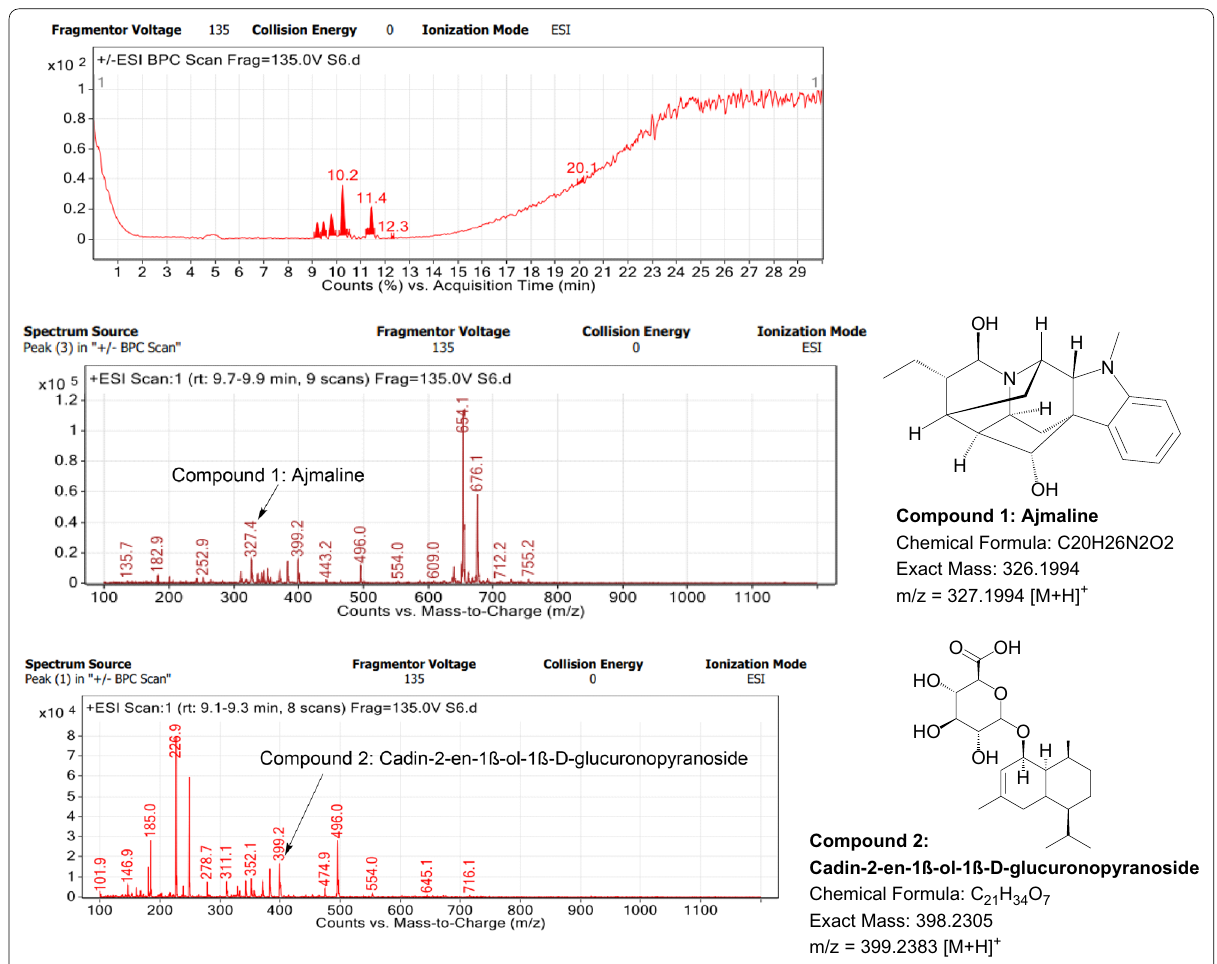
Fig. 12 LC–MS chromatogram of root extract of Catharanthus roseus showing marker